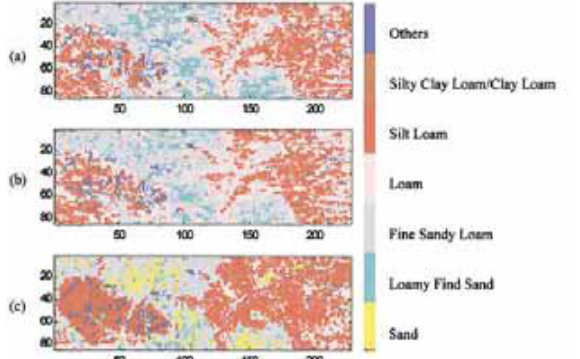
Fig.8: Comparison of the TFNN model estimated (a, b) and observed (c) soil texture (Chang and Islam 2000).